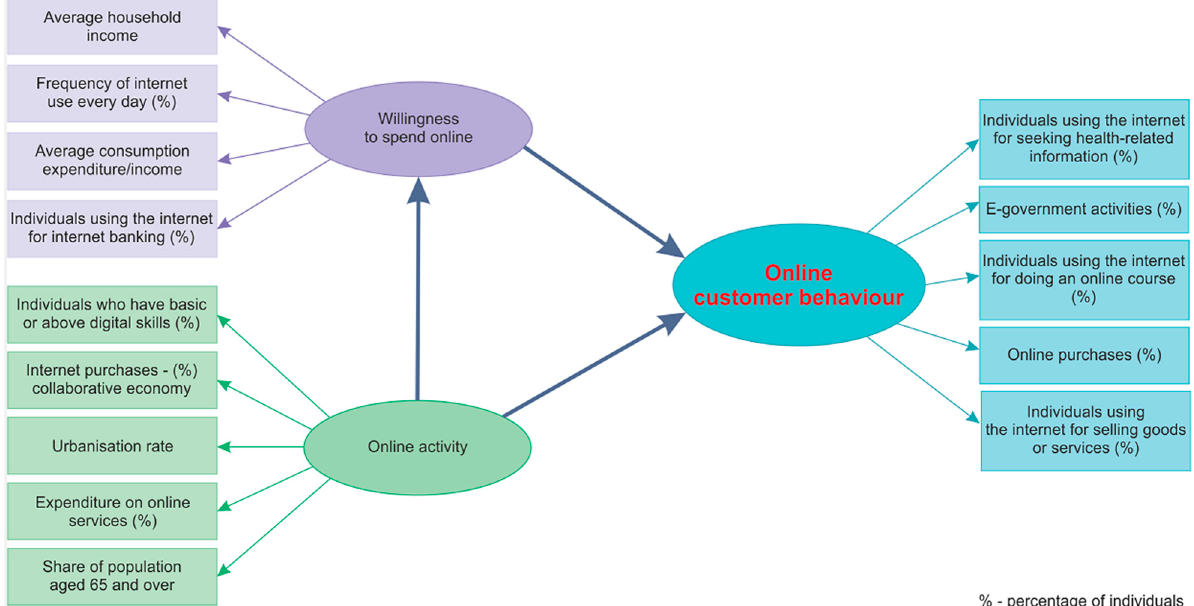
Figure 1. Scheme of a soft model showing online consumer behavior, in 2019–2020, for EU countries, with the directions of internal and external relationships indicated. Source, own study.